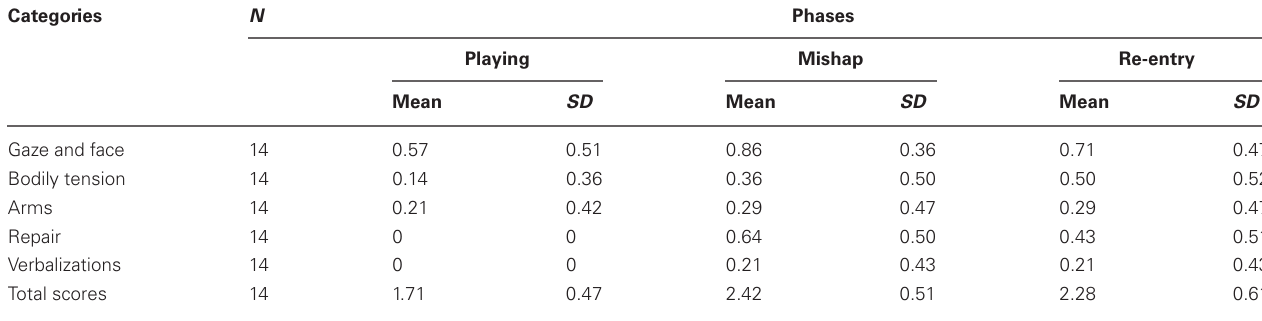
Table 2 | Means and standard deviation of the categories in all phases